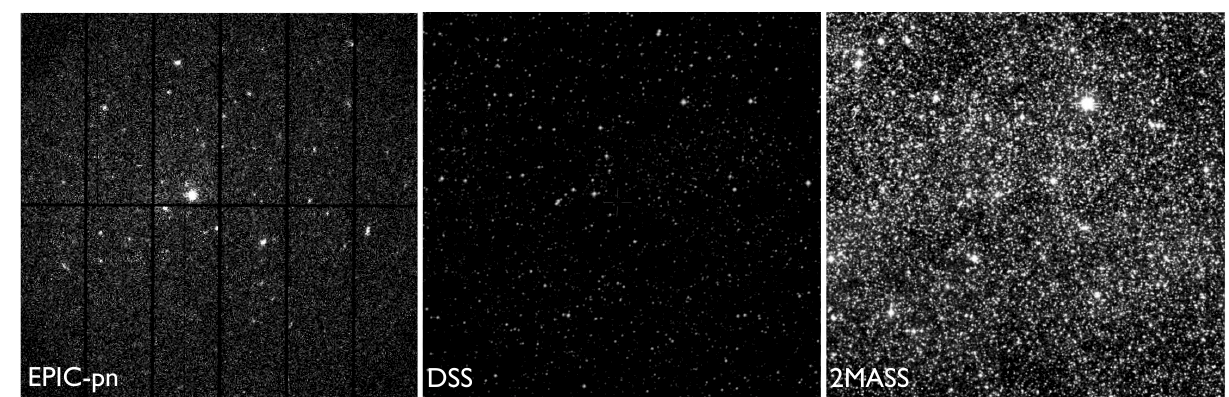
Figure 1: Example field studied in this survey. From left to right, X-ray (EPIC-pn), optical (DSS) and infrared (2MASS) images around the WR